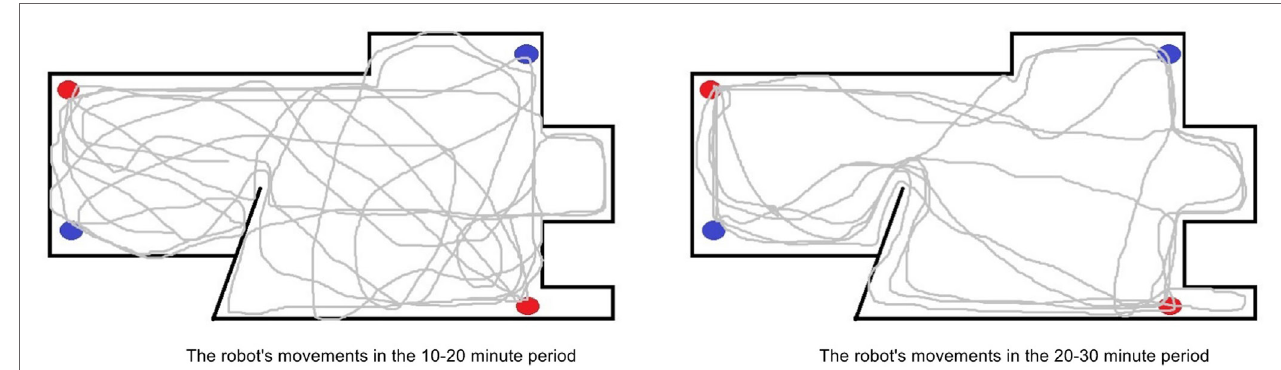
FigUre 6 | a comparison of the movement patterns of the robot in the standard environment in the 10–20 minute period of the experiment (left) and in the 20–30 minute period (right) . The red and blue dots represent the location of the health and energy resources respectively. Here, we can see that in the later period the robot movements become more purposeful moving directly between the different resources. It should be noted that the movement maps were created using data from the robot’s wheel speeds, rather than an overhead recording, therefore there may be some